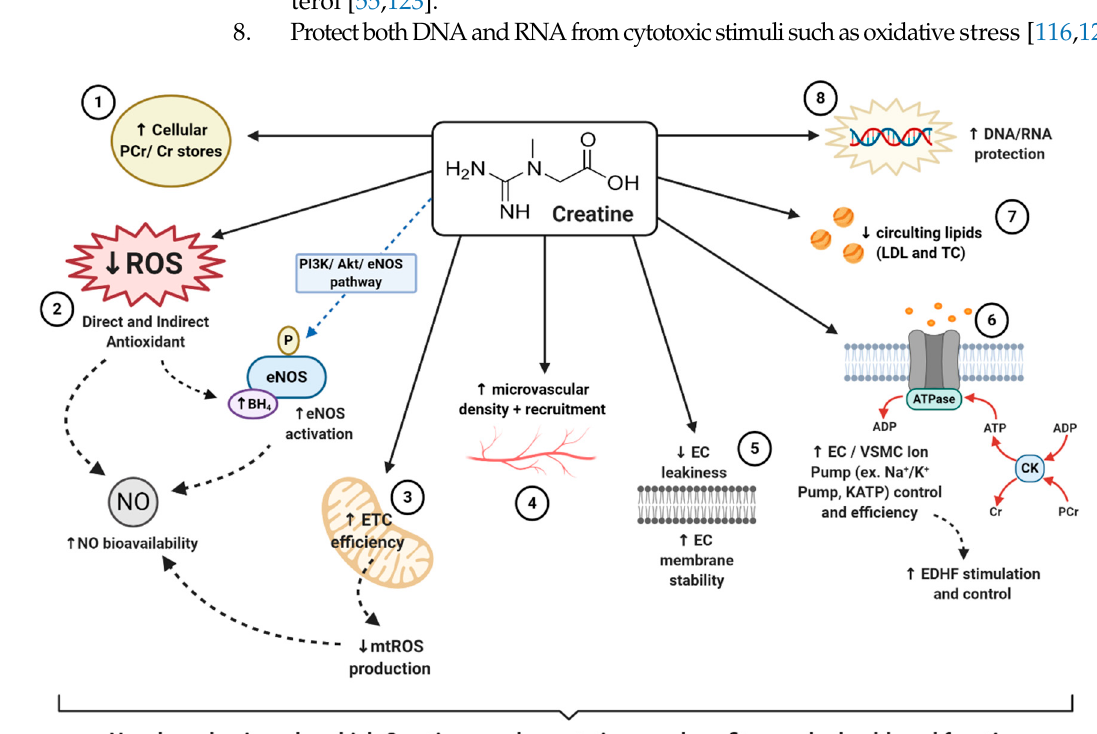
Figure 1. Novel mechanisms by which creatine supplementation may benefit vascular health and function; PCr = phos- phocreatine, Cr = creatine, EC = endothelial cell, DNA = deoxyribonucleic acid, RNA = ribonucleic acid, ETC = mitochon- dria electron transport chain, mtROS = mitochondrial-specific reactive oxygen species, ROS = reactive oxygen species, LDL = low density lipoprotein, TC = total cholesterol, PI3K/Akt/eNOS pathway = Phosphatidylinositol 3-kinase/Protein kinase B/endothelial nitric oxide synthase pathway, eNOS = endothelial nitric oxide synthase, P = phosphorylation, BH 4 = tetra- hydrobiopterin, NO = nitric oxide, ADP = adenosine diphosphate, ATP = adenosine triphosphate, CK = creatine kinase, VSMC = vascular smooth muscle cell, Na + /K + Pump = sodium/potassium pump, KATP = ATP-sensitive potassium pump, EDHF = endothelium-derived hyperpolarization factor, ↓ = decrease/reduction in, ↑ = increase in, “blue dashed line” = proposed pathway by Ahsan et al. [147], phosphorylation and stimulation of eNOS.